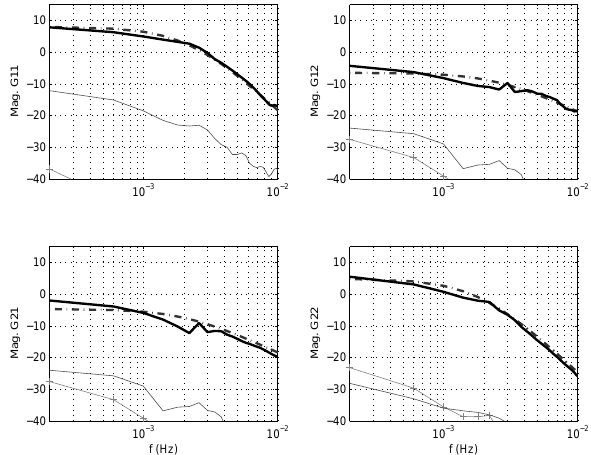
Figure 7: Estimated FRM of G BLA using LPA-FM of the simulated case with multisine excitation. Black: FRM of ˆ G BLA . Gray: Variances caused by noise. light Gray (-+): Variances caused by nonlinear distortions. dark Gray (- · ): FRM of G lin .